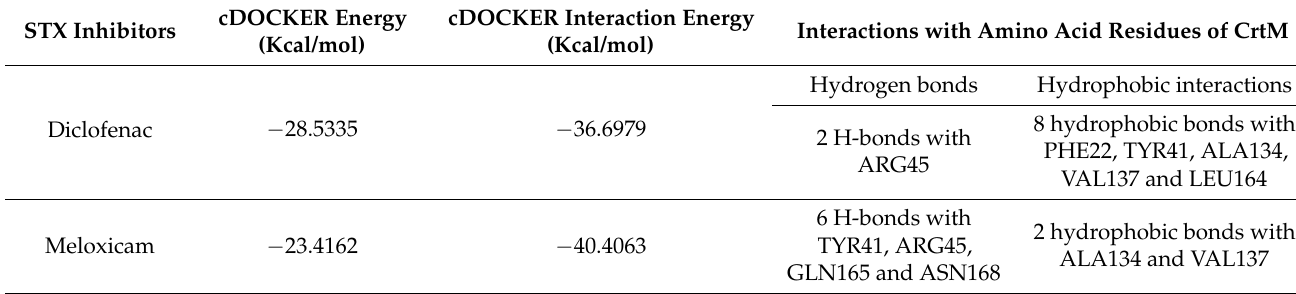
Table 2. Molecular modeling